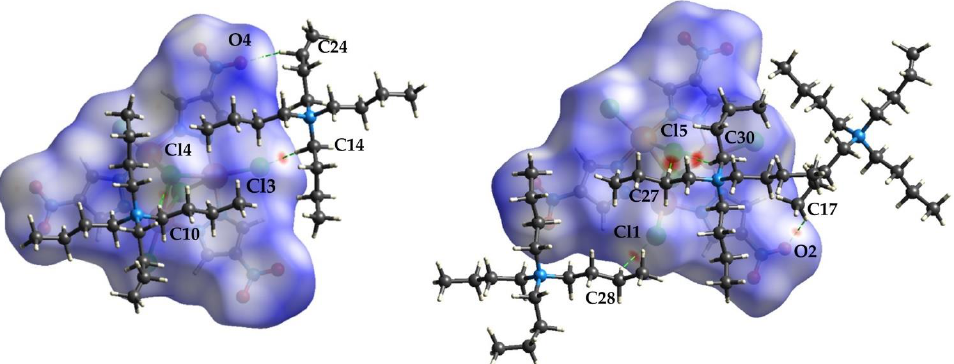
Figure 5. Hirshfeld surface of the front ( left ) and back ( right ) of the [Cu 3 (μ 3 -Cl) 2 (μ -4-NO 2 -pz) 3 Cl 3 ] 2- unit of 1a showing the intermolecular interactions with the tetrabutylammonium cations.